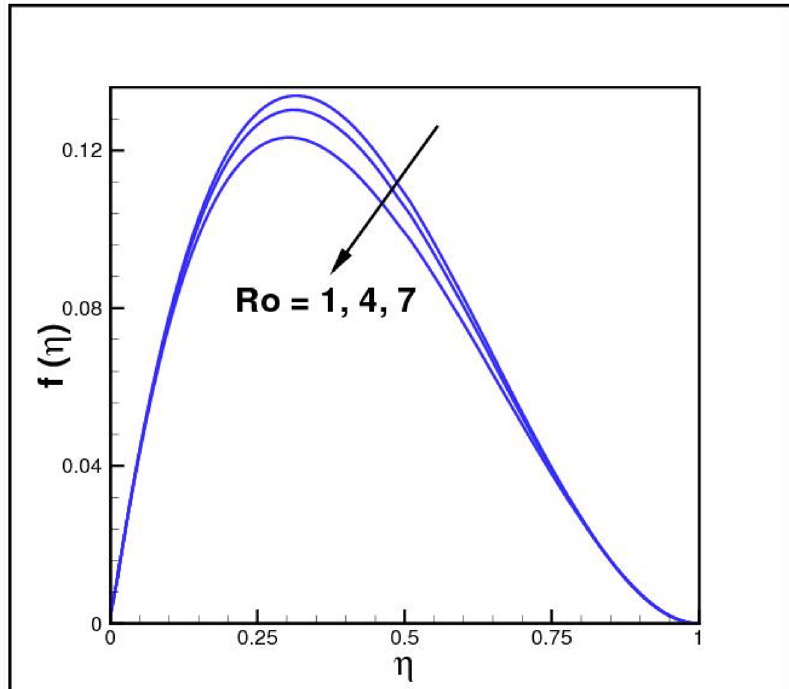
Figure 2. Impact of Ro on f ( η